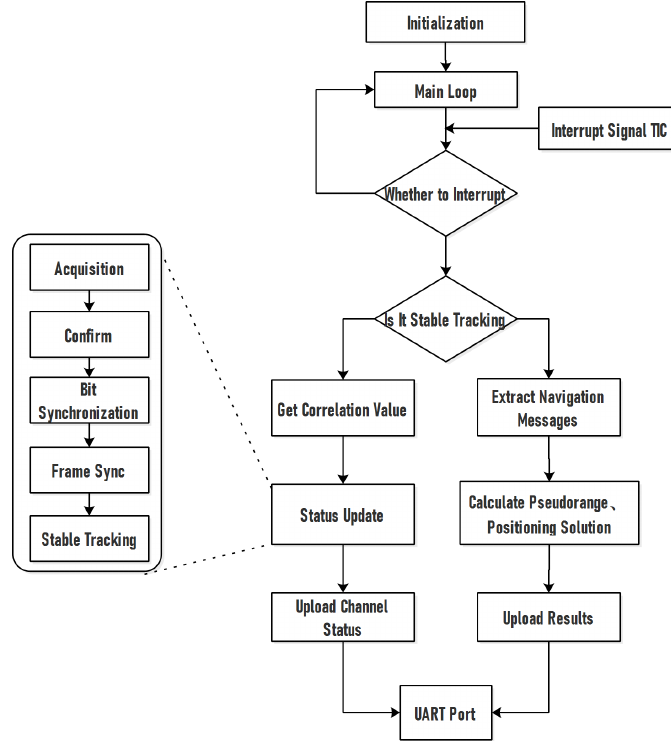
Figure 4. DSP signal processing